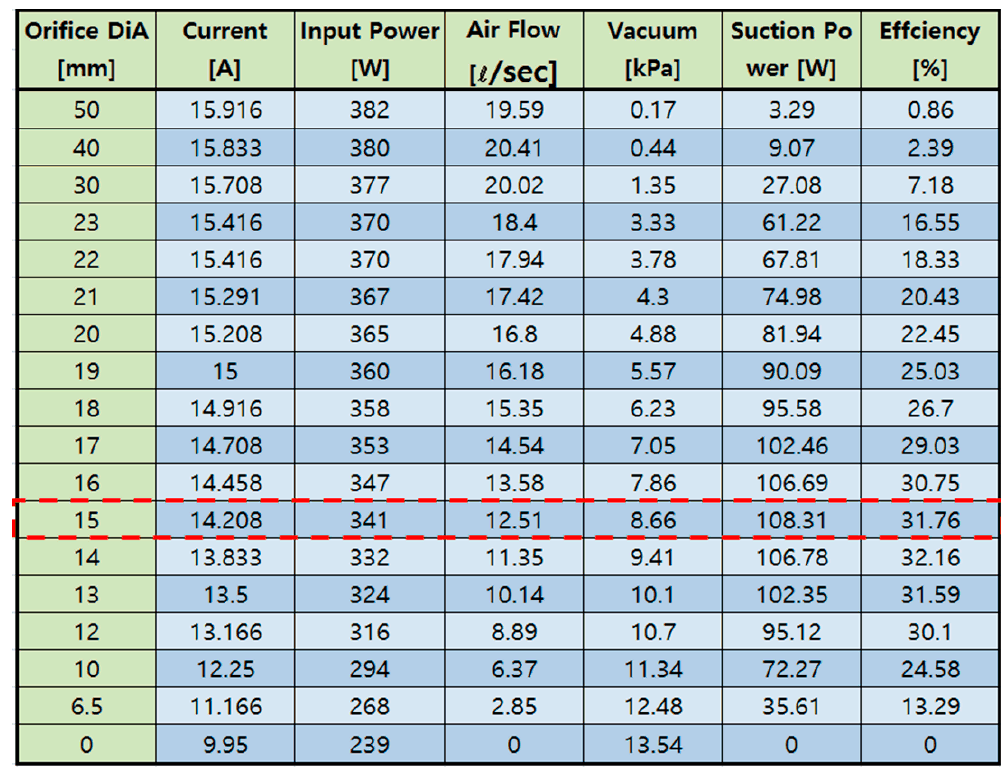
Figure 24. DC Motor suction power test data.